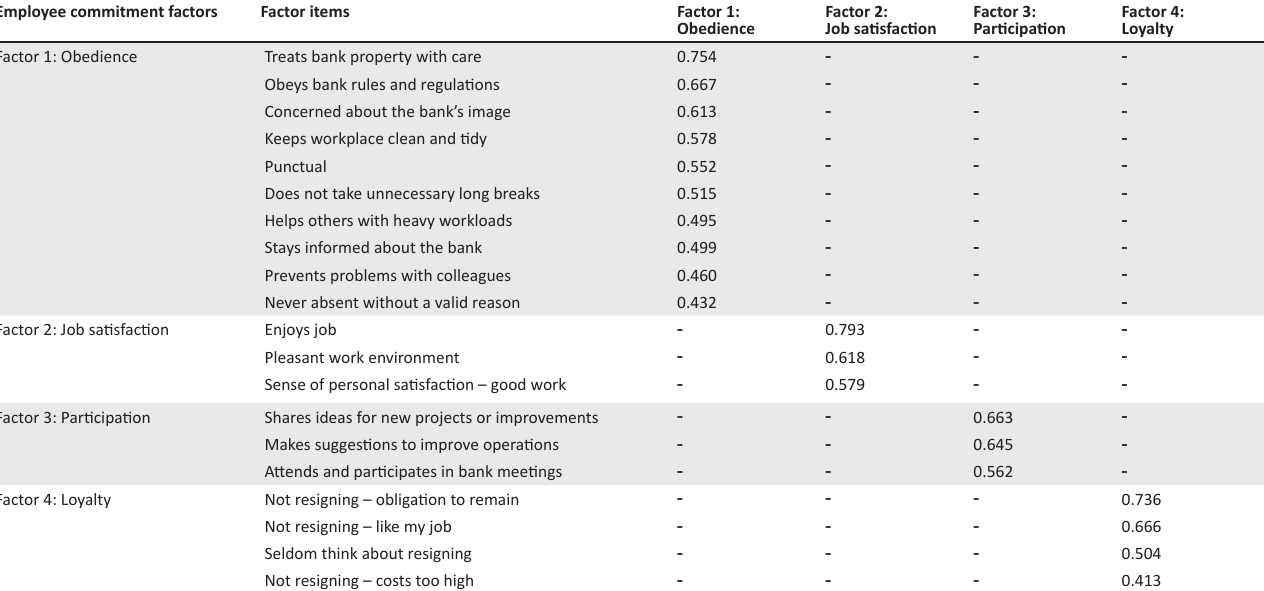
TABLE 2: Rotated factor matrix for employee commitment. Employee commitment